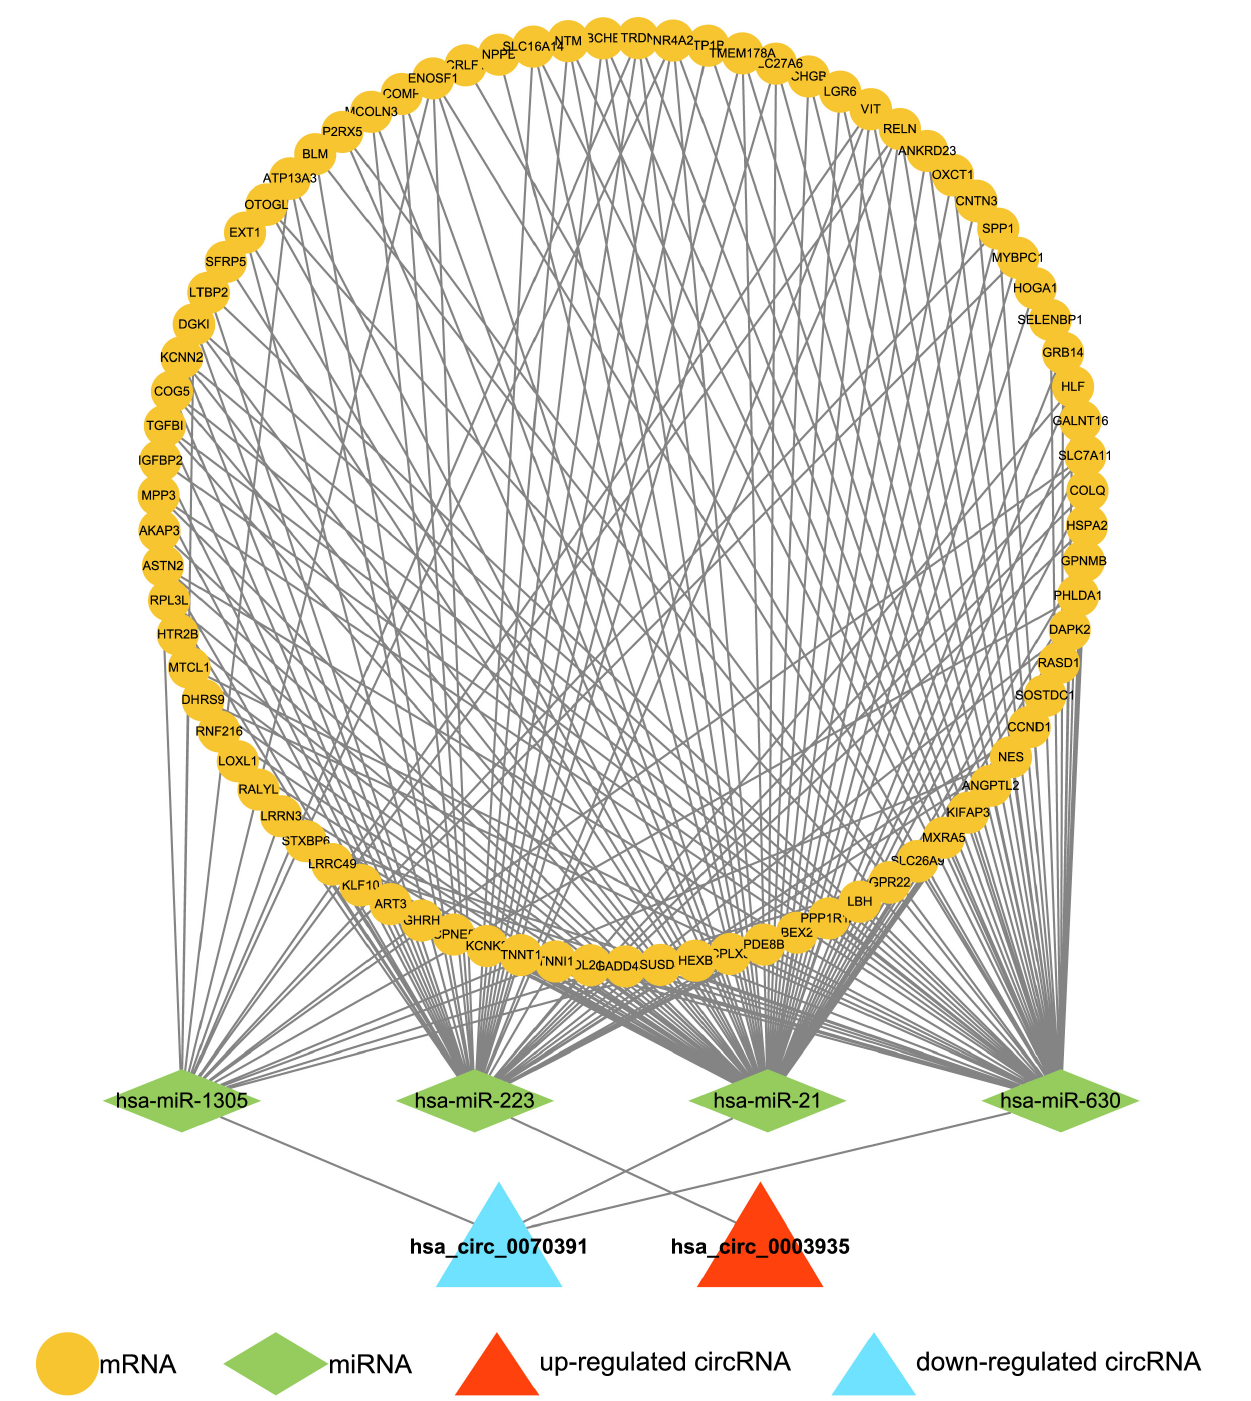
FIGURE 3 | Construction of the circRNA-miRNA-mRNA network. The circRNA-miRNA-mRNA network was developed by combining circRNA-miRNA pairs and miRNA-mRNA pairs, including 2 circRNAs, 4 miRNAs, and 83